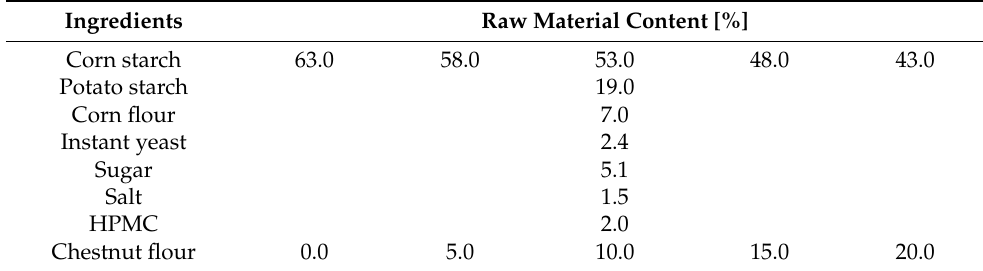
Table 1. The recipe composition of gluten-free bread concentrates.